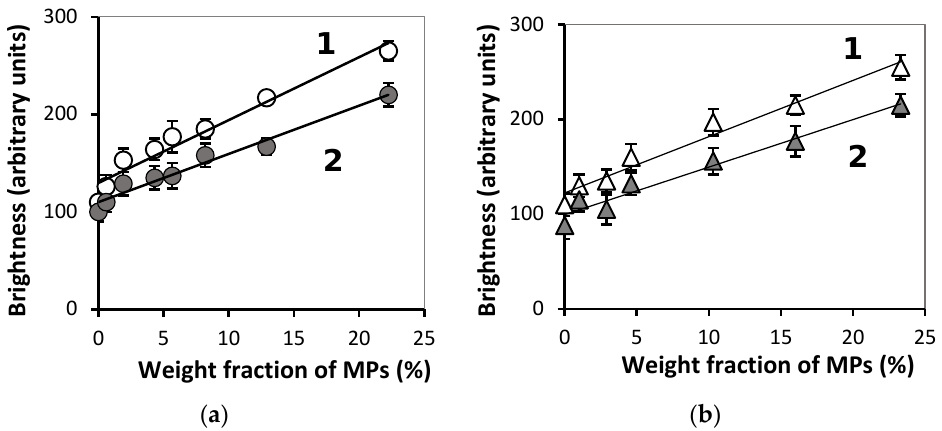
Figure 9. Dependences of maximal (1) and average brightness (2) at gel/water boundary on the MPs concentration for samples PAAm/Xanthan ( a ) and PAAm/Guar ( b ). Vertical bars reflect the confidence interval with p = 0.01 ( n = 60). Linear regressions with x being the concentration of iron oxide MPs in % (wt.): ( a ) I max = 6.5 x + 129.6 (R 2 = 0.953), I av = 4.9 x + 110 (R 2 = 0.968); ( b ) I max = 5.9 x + 122.4 (R 2 = 0.969), I av = 5.0 x + 99.5 (R 2 = 0.962).